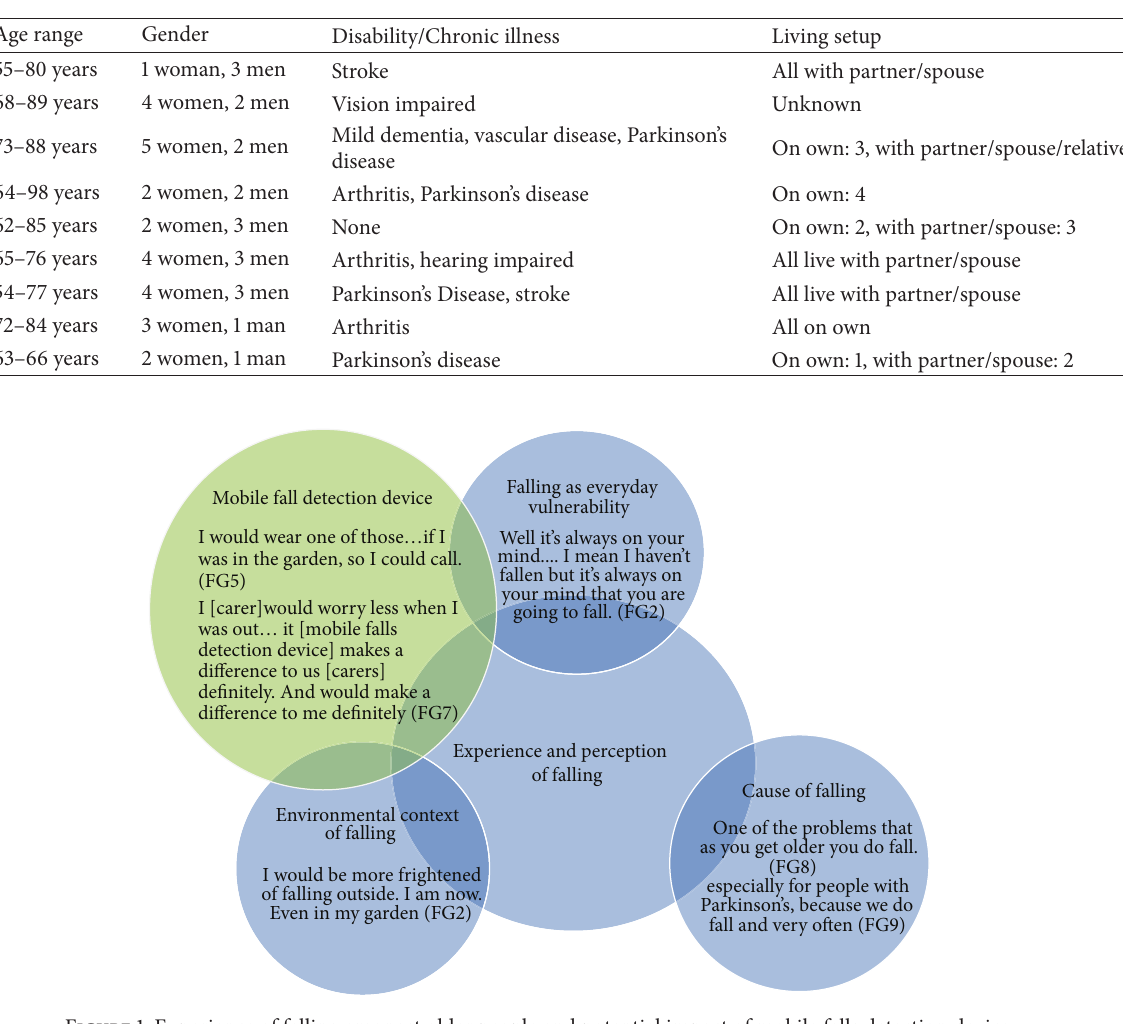
Table 1: Participant characteristics.